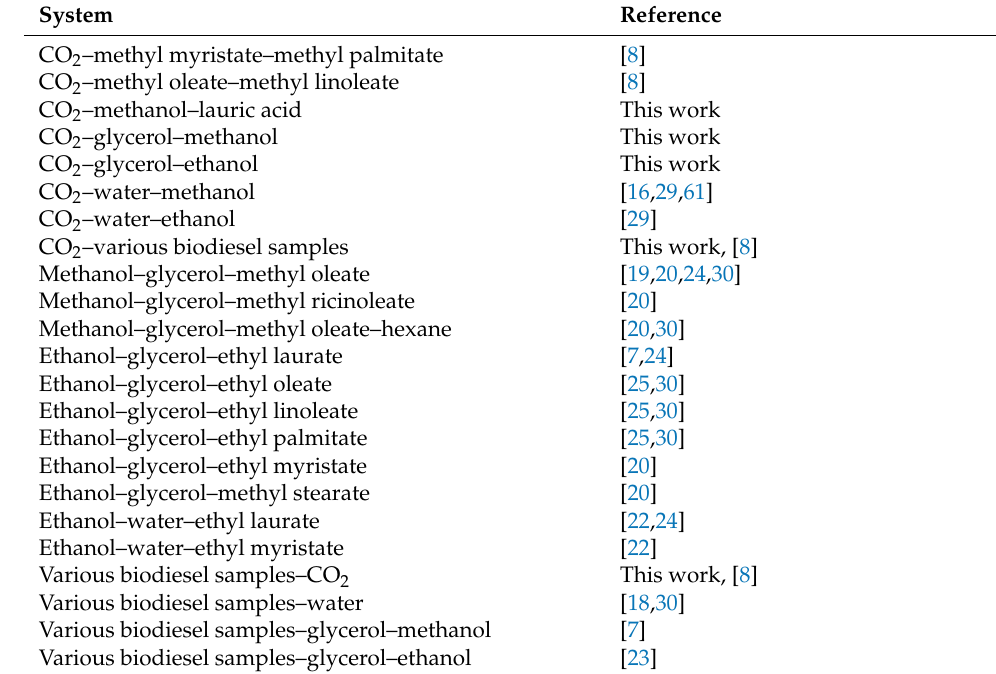
Table 7. Overview of multicomponent systems modeled with the CPA